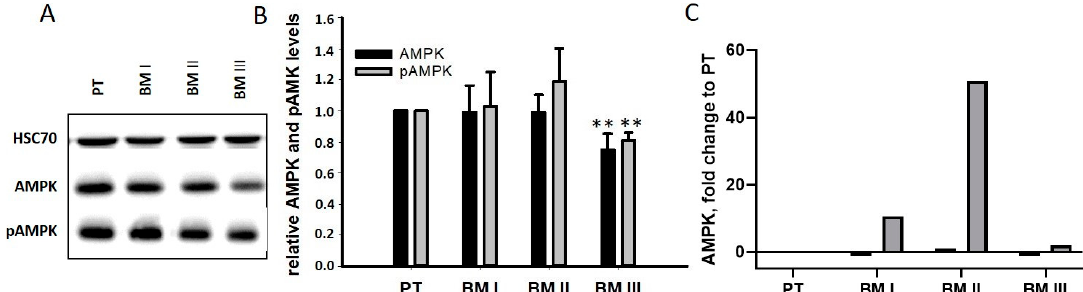
Figure 8. AMPK analysis. ( A , B ) Expression and phosphorylation (pAMPK) of AMPK, a target of MAGE-A3 [14], was analyzed by Western blotting. The uncropped blots are shown in Figure S2. ( B ) Shows densitometric analysis of the AMPK blots with mean + SD of three independent experiments. ** p < 0.005. The data obtained for PT were set to one. ( C ) Compensatory up-regulation of AMPK at the mRNA level was found in the transcriptome data.